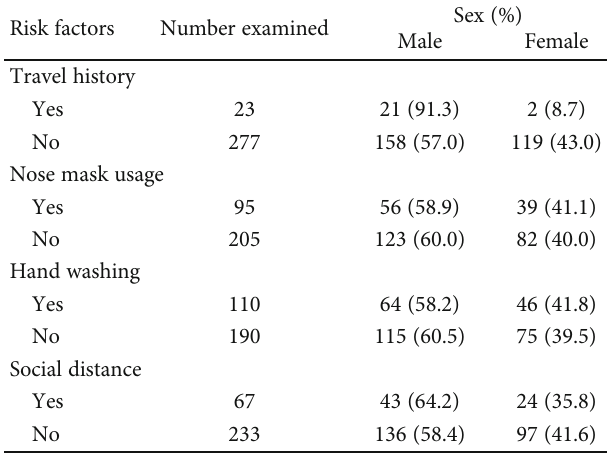
Table 3: Relationship between risk factors and sex among study